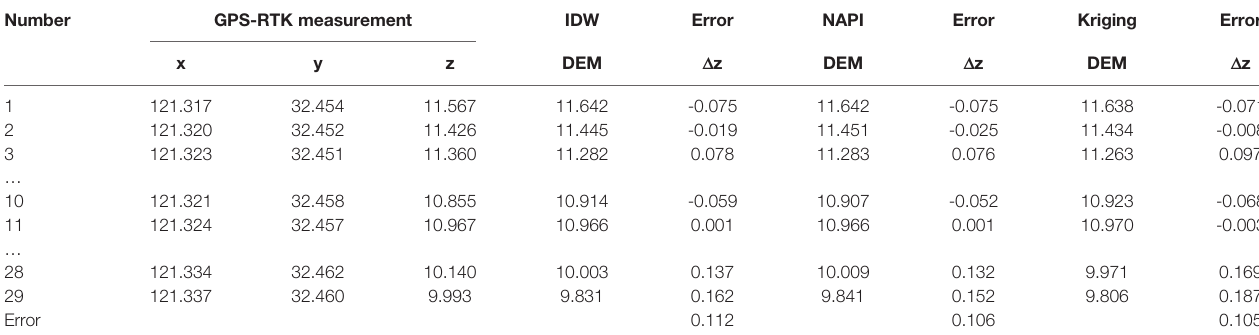
TABLE 4 | The accuracy evaluation of DEM.